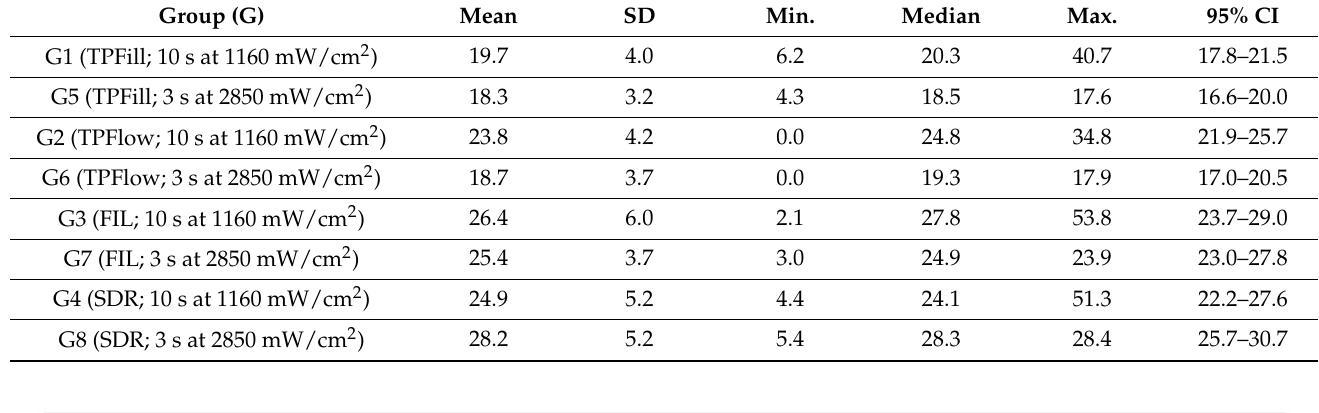
Table 2. Descriptive statistics of the micro-tensile bond strength (MPa) of all groups.